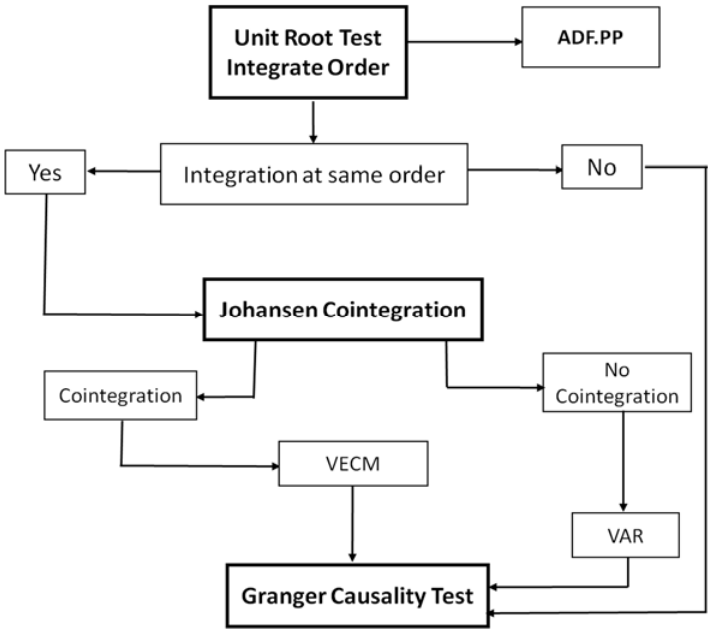
Figure 6. The methodology of the study.